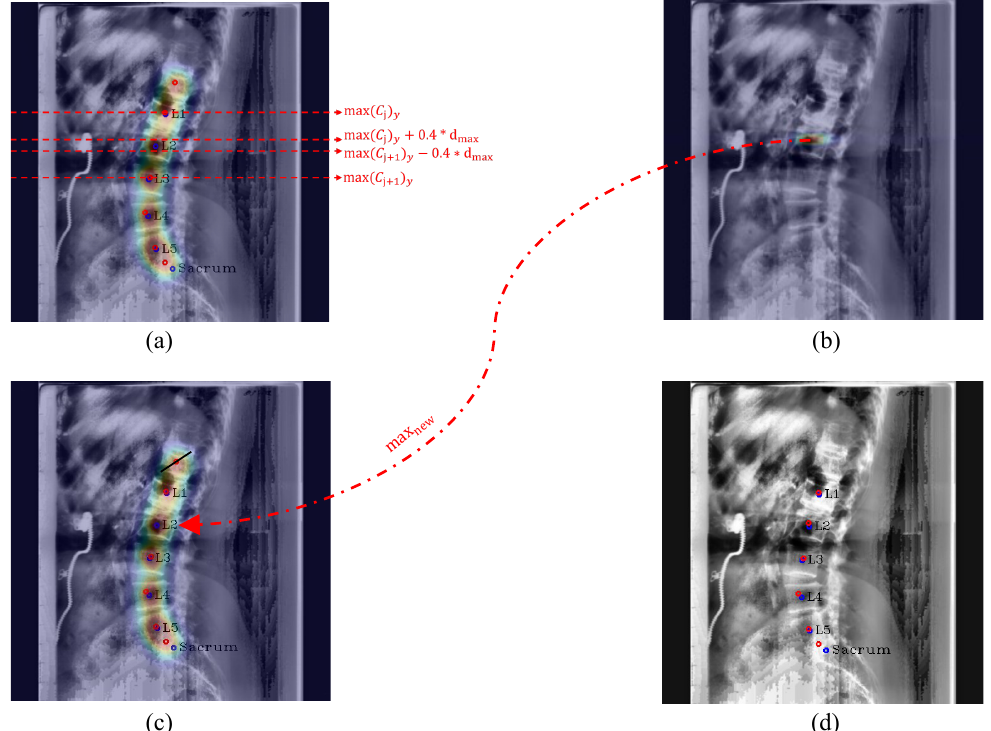
Figure 7. Post-processing procedure. ( a ) denotes the boundary lines to make the value of the confidence map zero, ( b ) denotes the generated confidence map of the unextracted center by using the previous boundary lines, ( c ) denotes the process of removing the incorrectly extracted center point of T12 and inserting the correct center point, and ( d ) denotes the final center points after post- processing. The red circles denote the predicated centers of L1, L2, L3, L4, L5, and the sacrum in order from the top, and the blue circles and labels denote the ground truth of the center of each